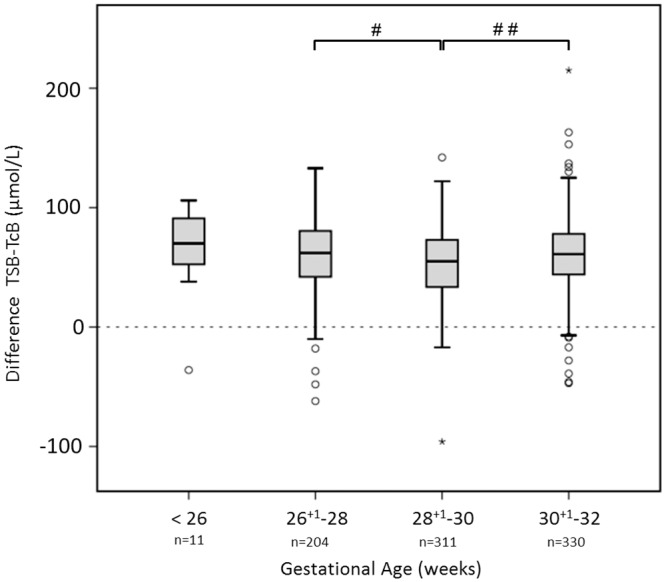
Gestational age categories and the mean difference between TSB and TcB.The y–axis displays the mean difference between TSB and TcB in μmol/L. TSB, total serum bilirubin in μmol/L; TcB, transcutaneous bilirubin in μmol/L; 17.1μmol/L = 1 mg/dL bilirubin. The median is marked by the horizontal line in the central box. The boxes are limited by the 25th and 75th percentiles. The whiskers (┴) represent the minimum and maximum TSB and TcB levels. Outliers (○) and extremes (star symbol) are depicted separately. The dashed line is the line at origin. Significant differences between groups are marked in the top of Fig 4 by # (P < 0.05) or ## (P < 0.01), respectively.